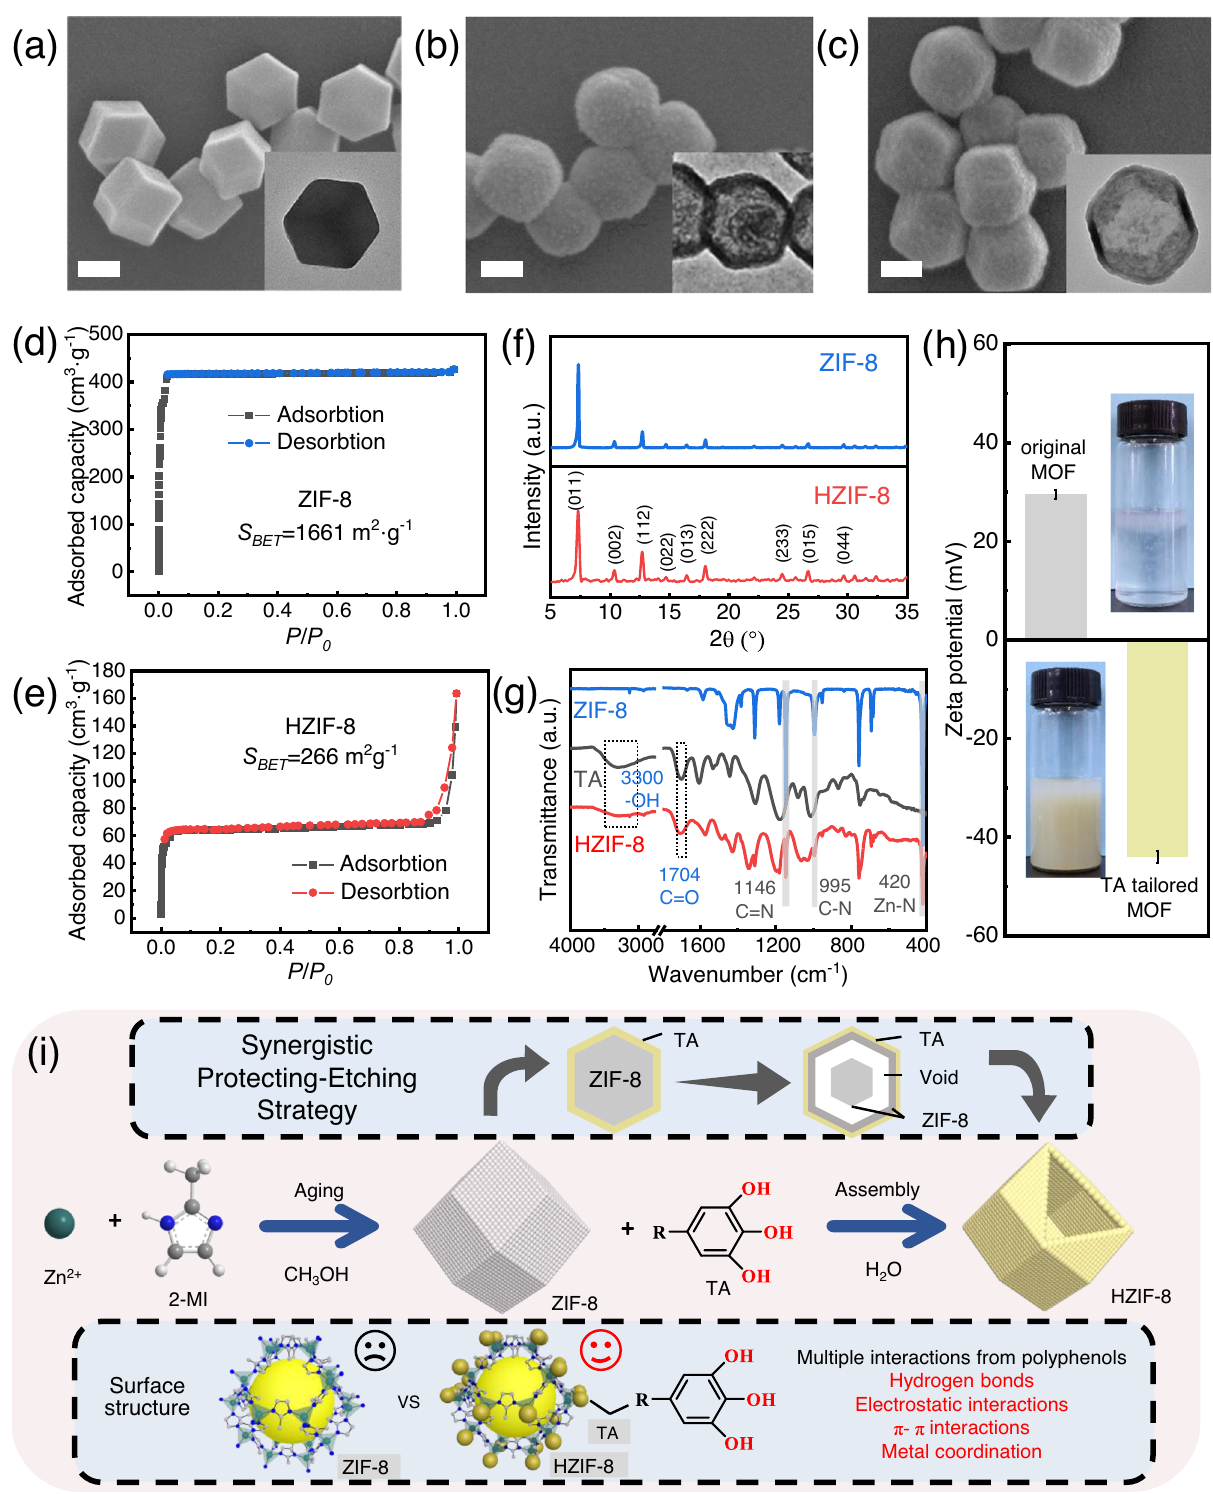
Fig. 1 | Effects of polyphenols on the physicochemical properties of MOF nanoparticlesandthesynthesismechanismofhollowMOFs.a – c SEMimagesof ZIF-8 nanoparticles at different reaction times, a 0min, b 2min, and c 5min. The inset picture is the corresponding TEM image (scale bars, 100nm); d , e N 2 adsorption-desorptionisothermsofZIF-8( d )andHZIF-8( e ); f XRD patternsofZIF- 8andHZIF-8; g FT-IRspectraofTA,ZIF-8,andHZIF-8; h ZetapotentialofZIF-8and